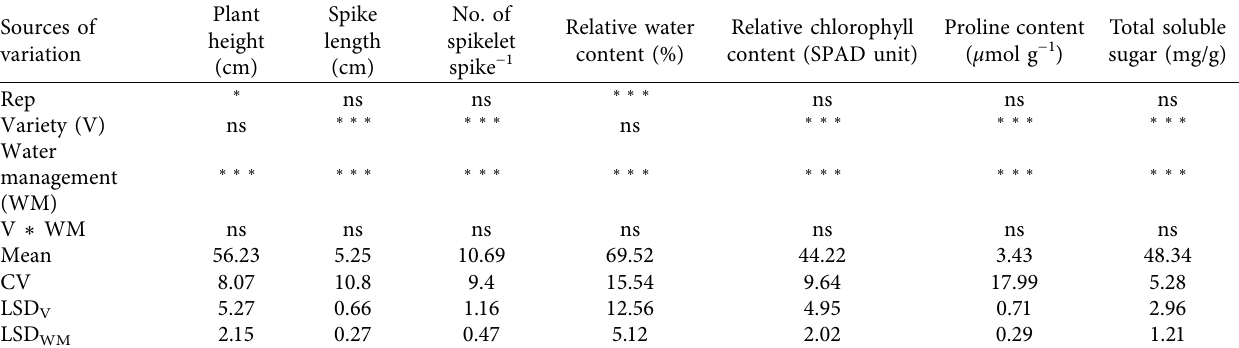
Table 3: ANOVA table for the influence of varieties and water management on morphological, physiological, and biochemical char- acteristics of wheat.